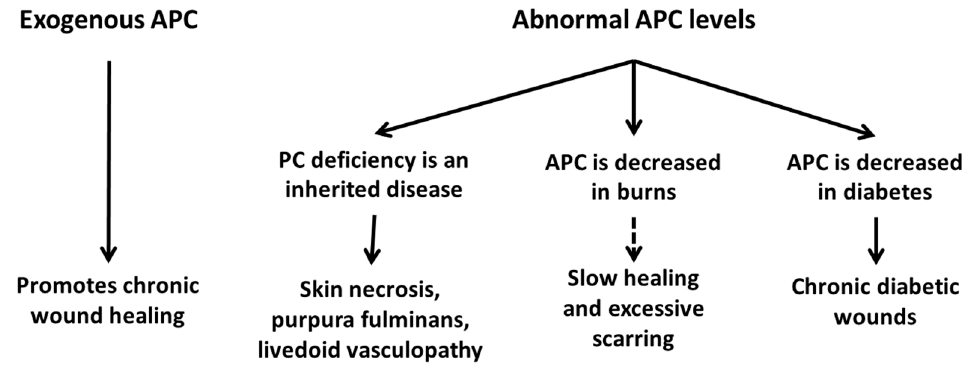
Figure 5. In humans, low APC levels are associated with chronic diabetic wounds, severe burn injuries, and skin necrosis secondary to purpura fulminans. Exogenous APC has been shown to promote the healing of chronic wounds of varying aetiologies.